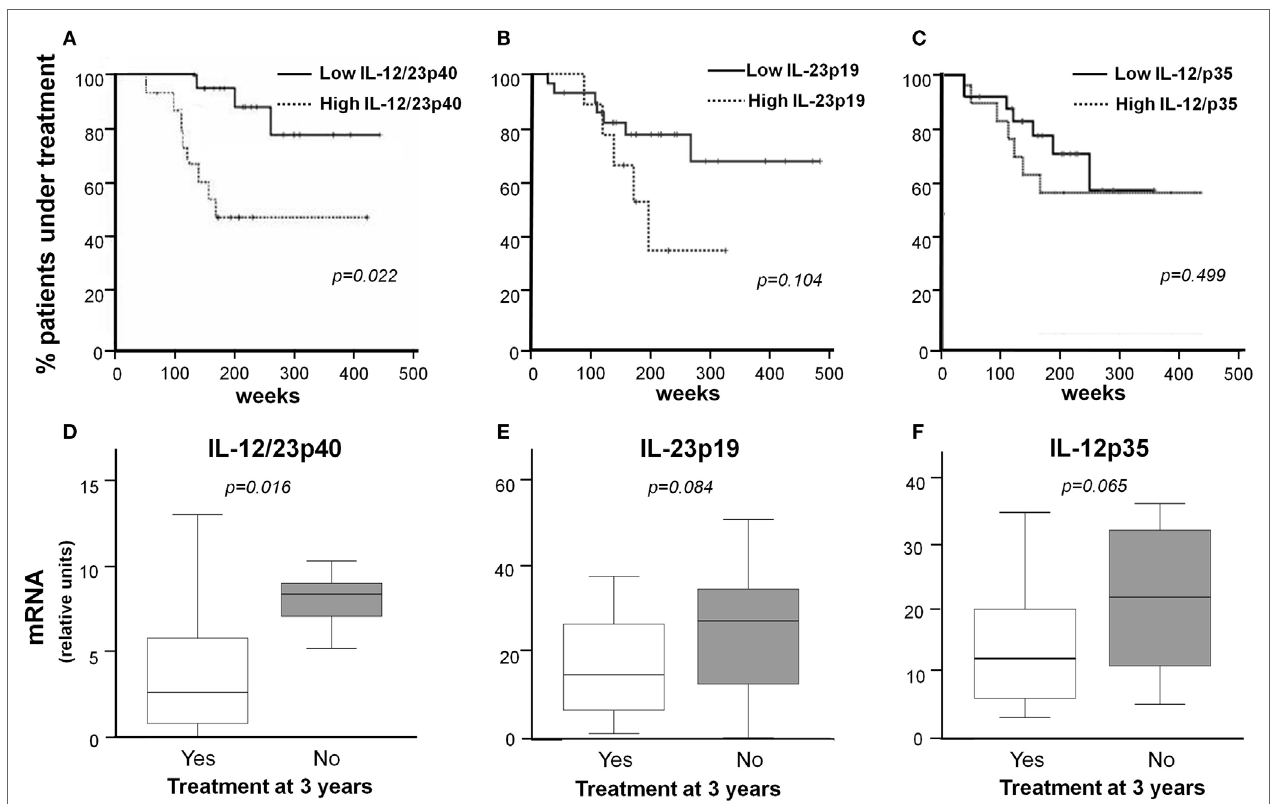
FigUre 5 | IL-12/23p40, IL-12/23p19, and IL-12p35 mRNA expression in lesions and long-term response to therapy. Percentage of treatment-naïve GCA patients requiring prednisone treatment over time, according to the intensity of IL-12/23p40 (a) , IL-12/23p19 (B) , and IL-12p35 (c) mRNA expression, in temporal artery lesions. High refers to mRNA levels above the 75th percentile ( N = 26), and low below the 75th percentile ( N = 10). IL-12/23p40 (D) , IL-23p19 (e) , and IL-12p35 (F) mRNA concentrations in initial temporal artery biopsies from patients still requiring prednisone ( N = 12) compared with patients in sustained remission ( N = 24), 3 years after